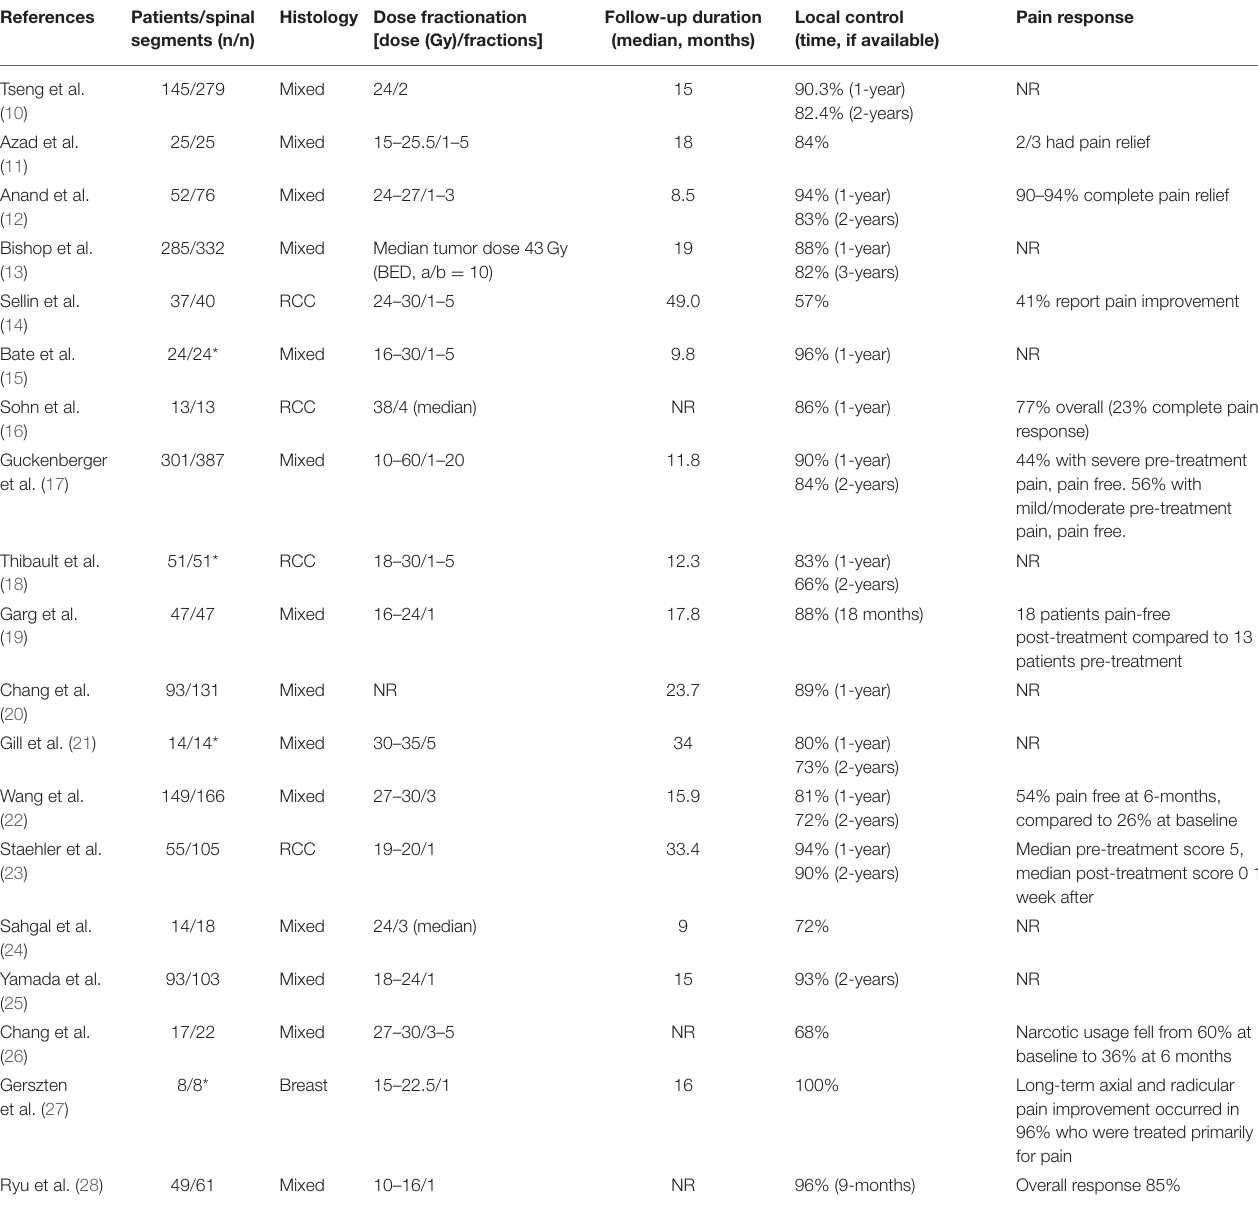
TABLE 1 | Outcomes after spine SBRT for de novo